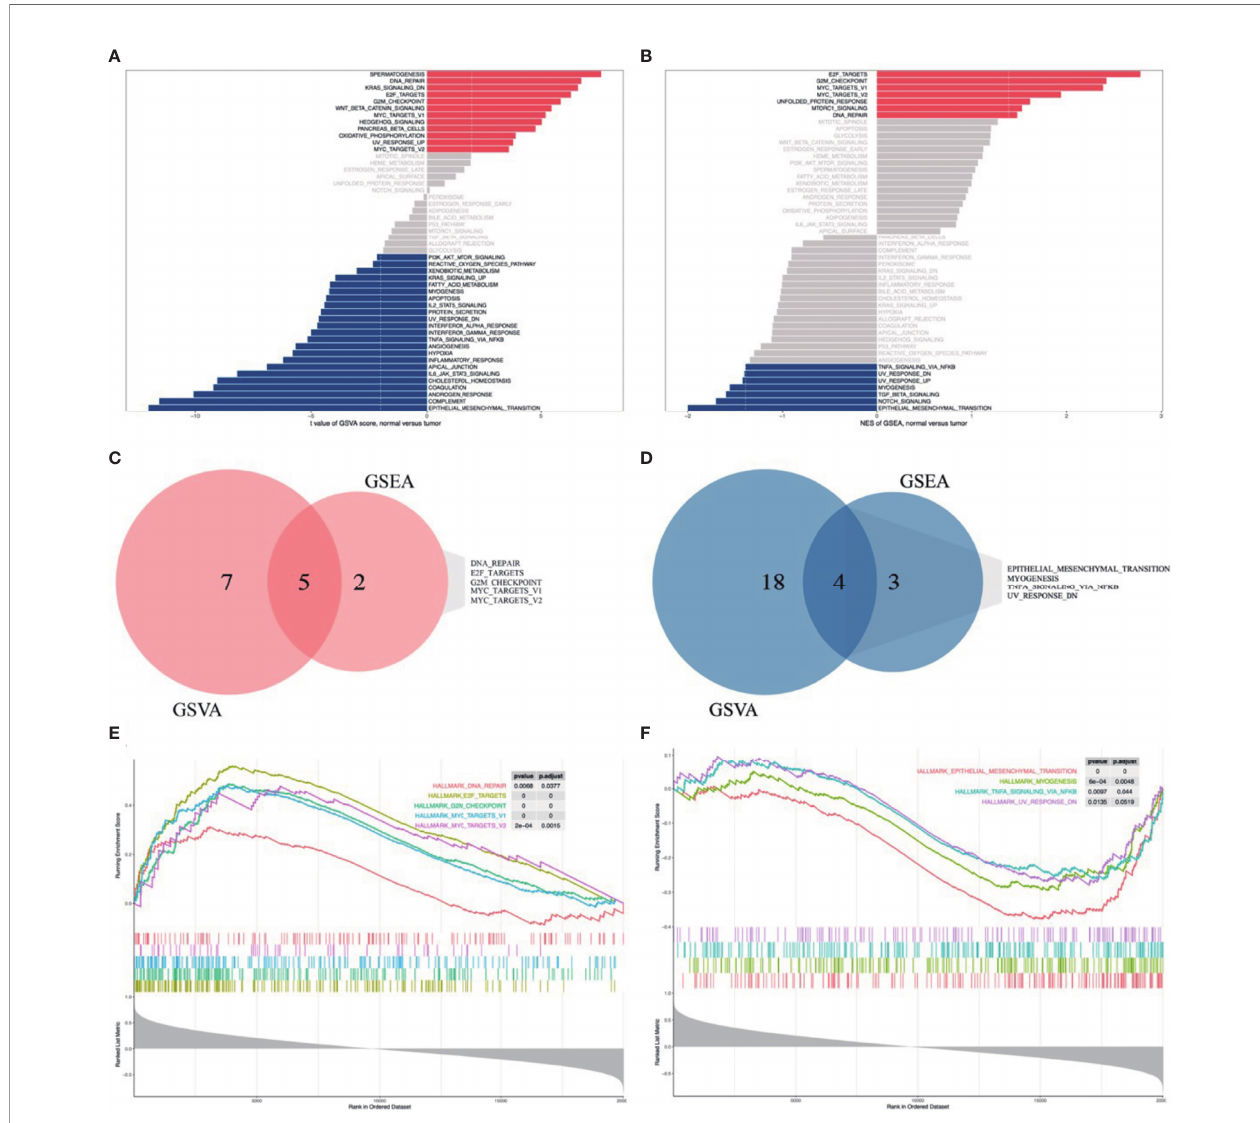
FIGURE 5 | FOXP4-AS1-related signaling cascades based on genes identi fi ed from GSEA and GSVA databases. (A, B) Bar graphs showing results of GSVA and GSEA, respectively. All cascades, except gray, were signi fi cantly enriched (p < 0.05). (C, E) A Venn diagram and GSEA plot showing the commonly up-regulated cascades across GSVA and GSEA datasets. (D, F) A Venn diagram and GSEA plot showing the commonly down-regulated cascades across GSVA and GSEA